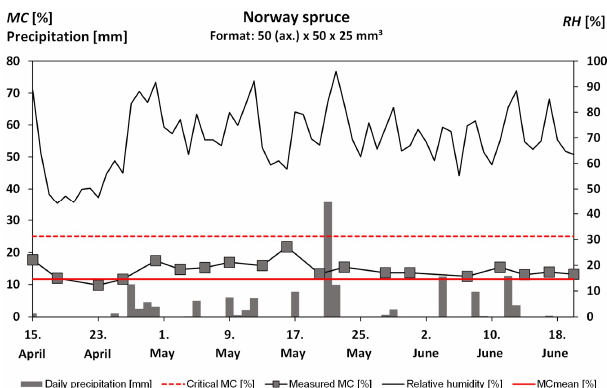
Figure 4. Wood moisture content ( MC ) development in Norway spruce specimens (50 (ax.) × 50 × 25 mm 3 ) exposed horizontally in open field and corresponding relative humidity ( RH ) (%), precipitation (mm), mean MC ( MC mean ) (%) and critical moisture conditions for the growth and infestation by wood-destroying fungi (critical MC %). Table 6. Mean moisture content ( MC mean ) of different softwoods, hardwoods, modified wood and preservative-treated wood detected during free-ventilated horizontal outside exposure (test field in